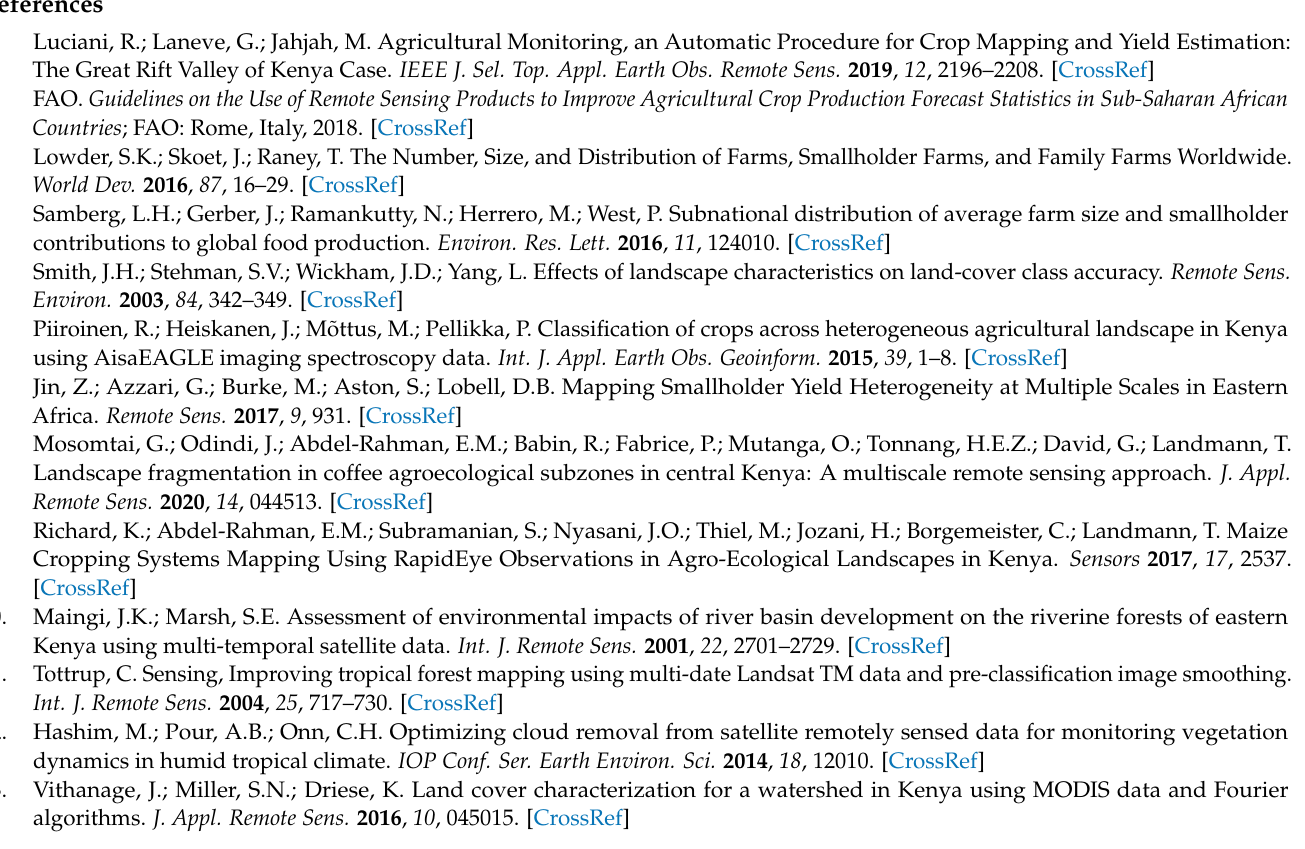
Figure A1. Learning curves of RF classification for each AEZ. With an increasing number of trees, the out-of-bag accuracy increases and converges to a threshold.